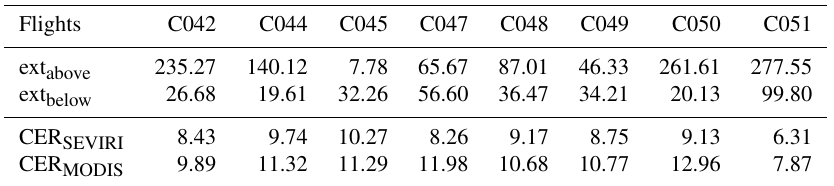
Table 2. Dry extinction (ext) measured by EXSCALABAR at 405nm averaged over 100m above and below the cloud (Mm − 1 ) and collocated CER (µm) retrieved by SEVIRI and MODIS.